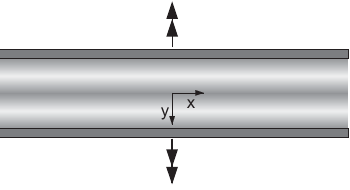
Figure 8: Load case 6